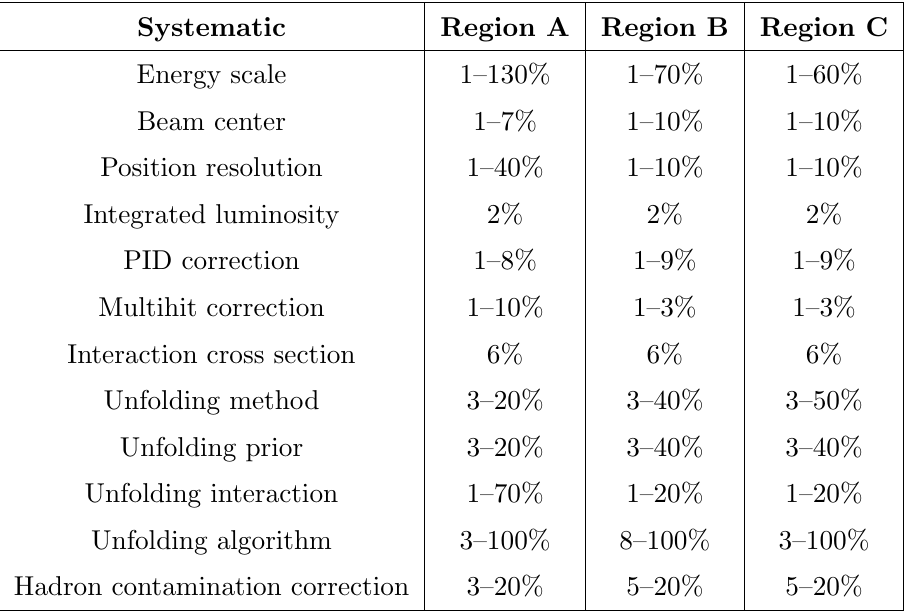
Table 4 . Minimum-maximum value of the relative systematic uncertainties for each contribution discussed in section 5.4, separately reported for pseudorapidity regions A, B and